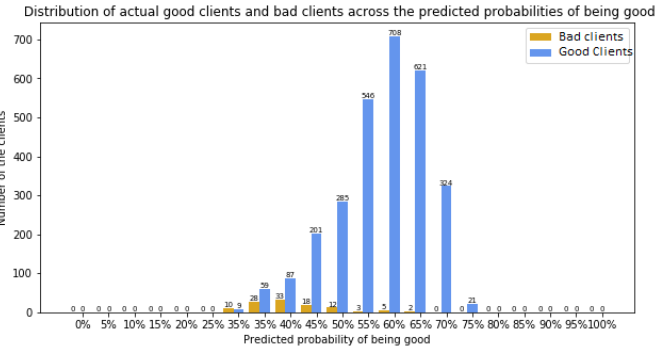
Figure 2. Distribution of good and bad customers with a balanced random forest